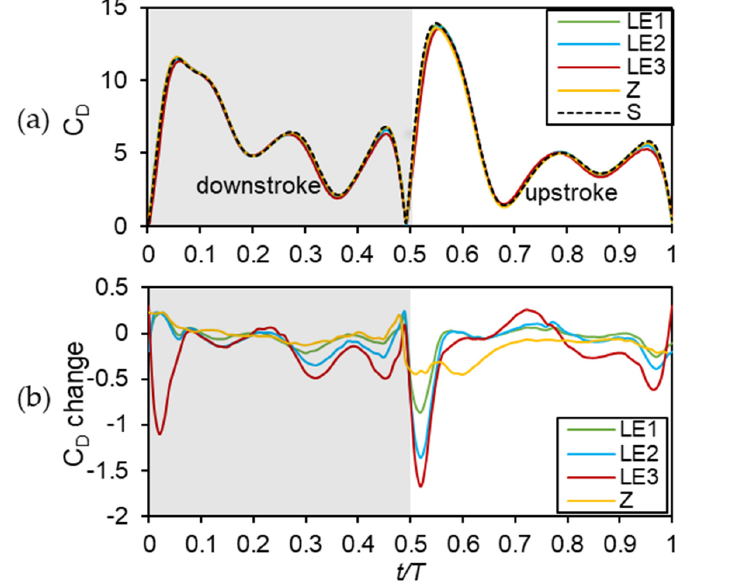
Figure 8. Comparison of drag coe ffi cient: ( a ) time courses of drag coe ffi cient (C D ) and ( b ) the changes in the drag coe ffi cients (C D change) of the LE1, LE2, and LE3 wings, compared to those of the S wing, at r = 0.375 R